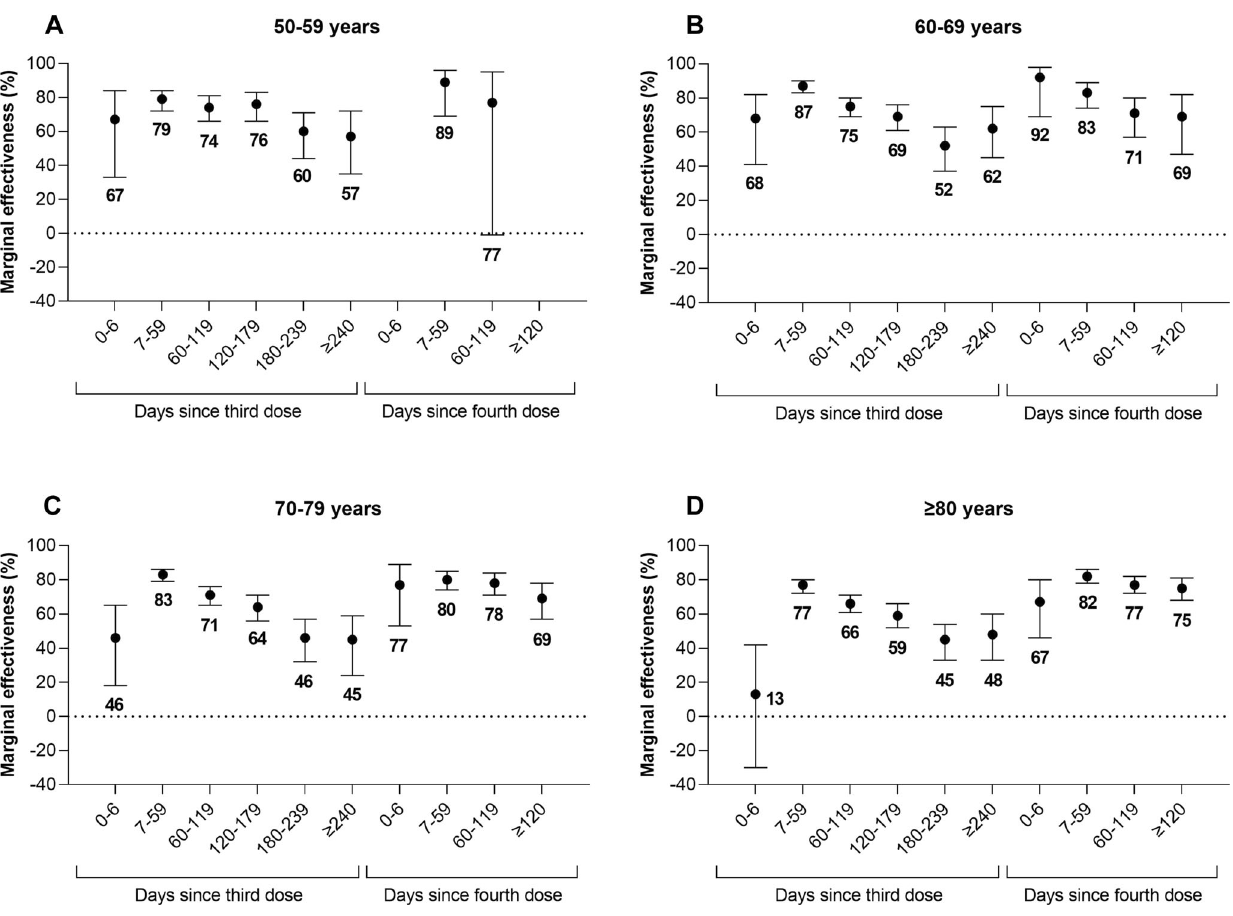
Fig. 2 | Marginal effectiveness and 95% con fi dence intervals by time since vaccination. Marginal effectiveness (presented as proportions out of 100 per- centage points) and 95% con fi dence intervals of a third and fourth dose of mono- valent mRNA COVID-19 vaccines against Omicron-associated severe outcomes by timesincevaccinationamongcommunity-dwellingadultsaged( A )50 – 59years,( B )